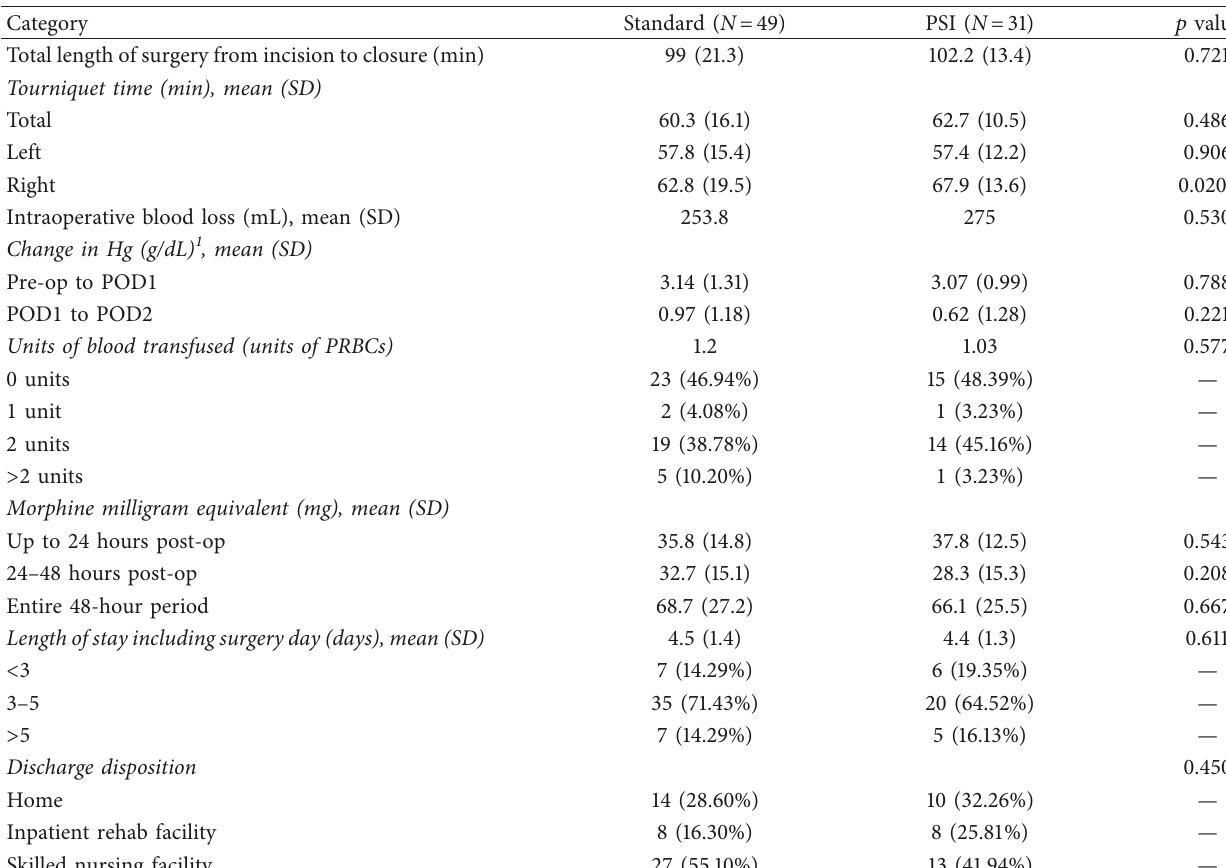
Table 2: Perioperative outcomes between